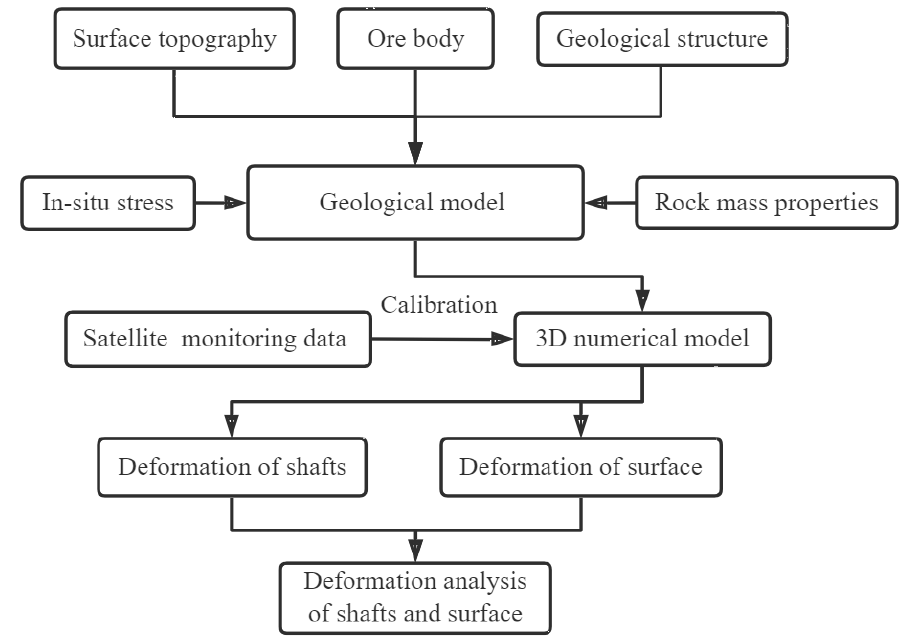
Figure 7. Flowchart of the method to analysis shafts and surface.